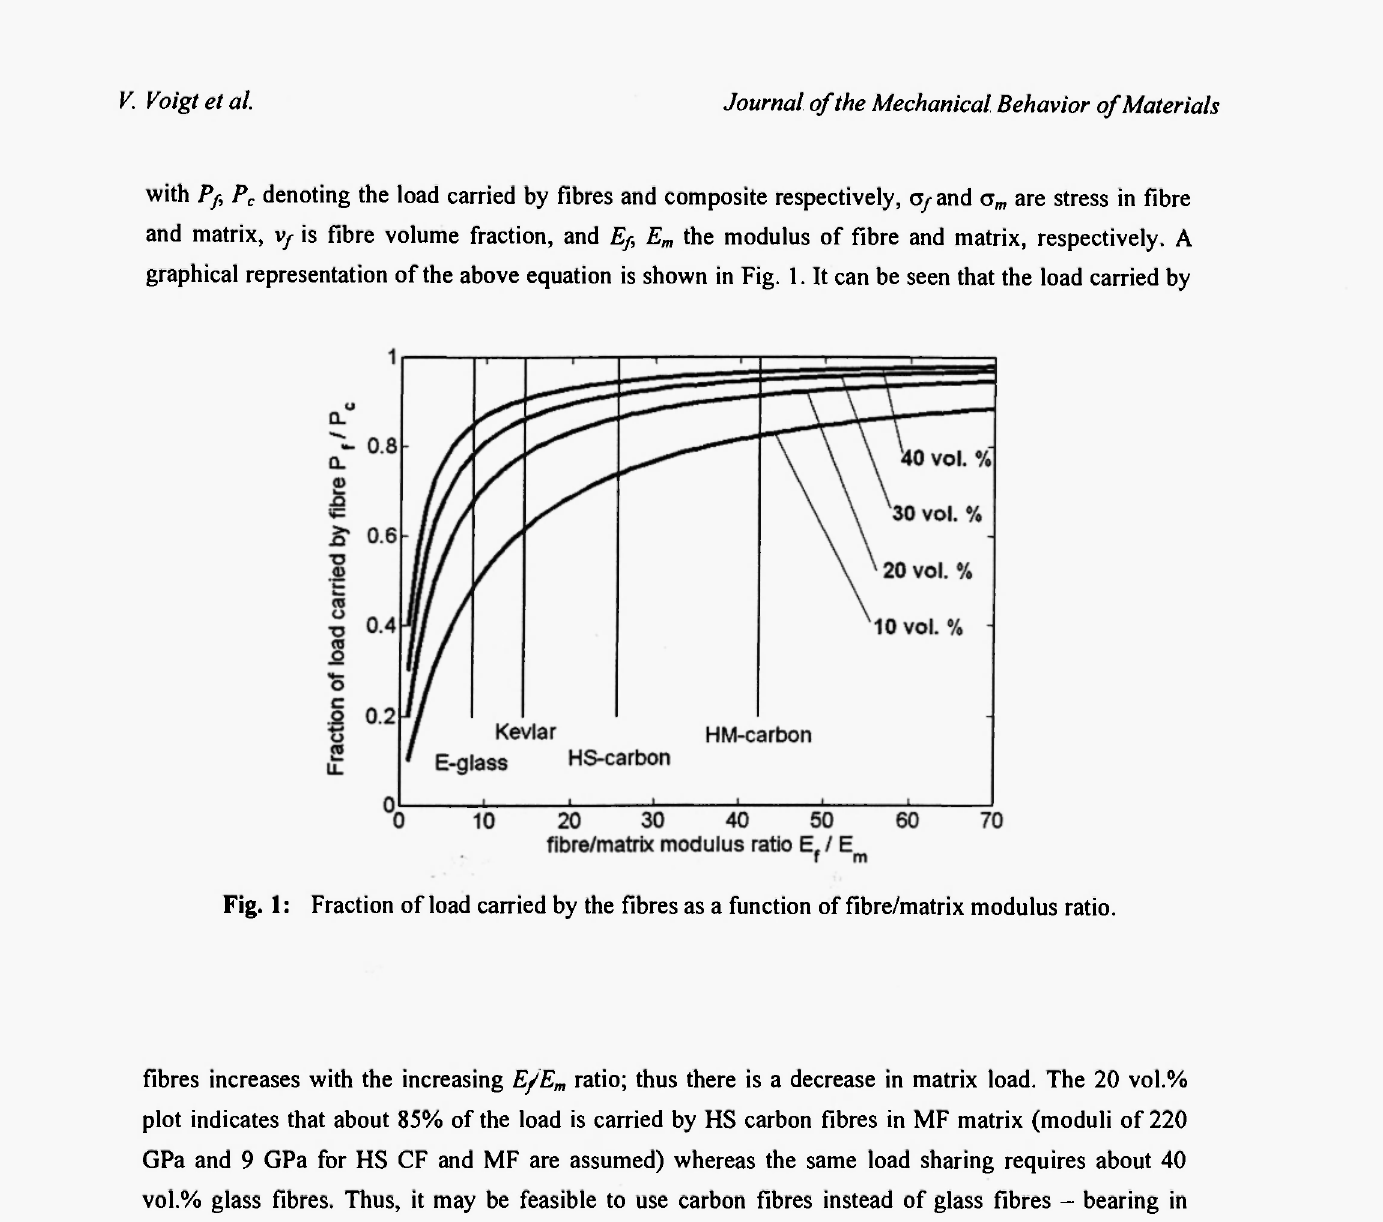
fibres increases with the increasing E/E m ratio; thus there is a decrease in matrix load. The 20 vol.% plot indicates that about 85% of the load is carried by HS carbon fibres in MF matrix (moduli of 220 GPa and 9 GPa for HS CF and MF are assumed) whereas the same load sharing requires about 40 vol.% glass fibres. Thus, it may be feasible to use carbon fibres instead of glass fibres - bearing